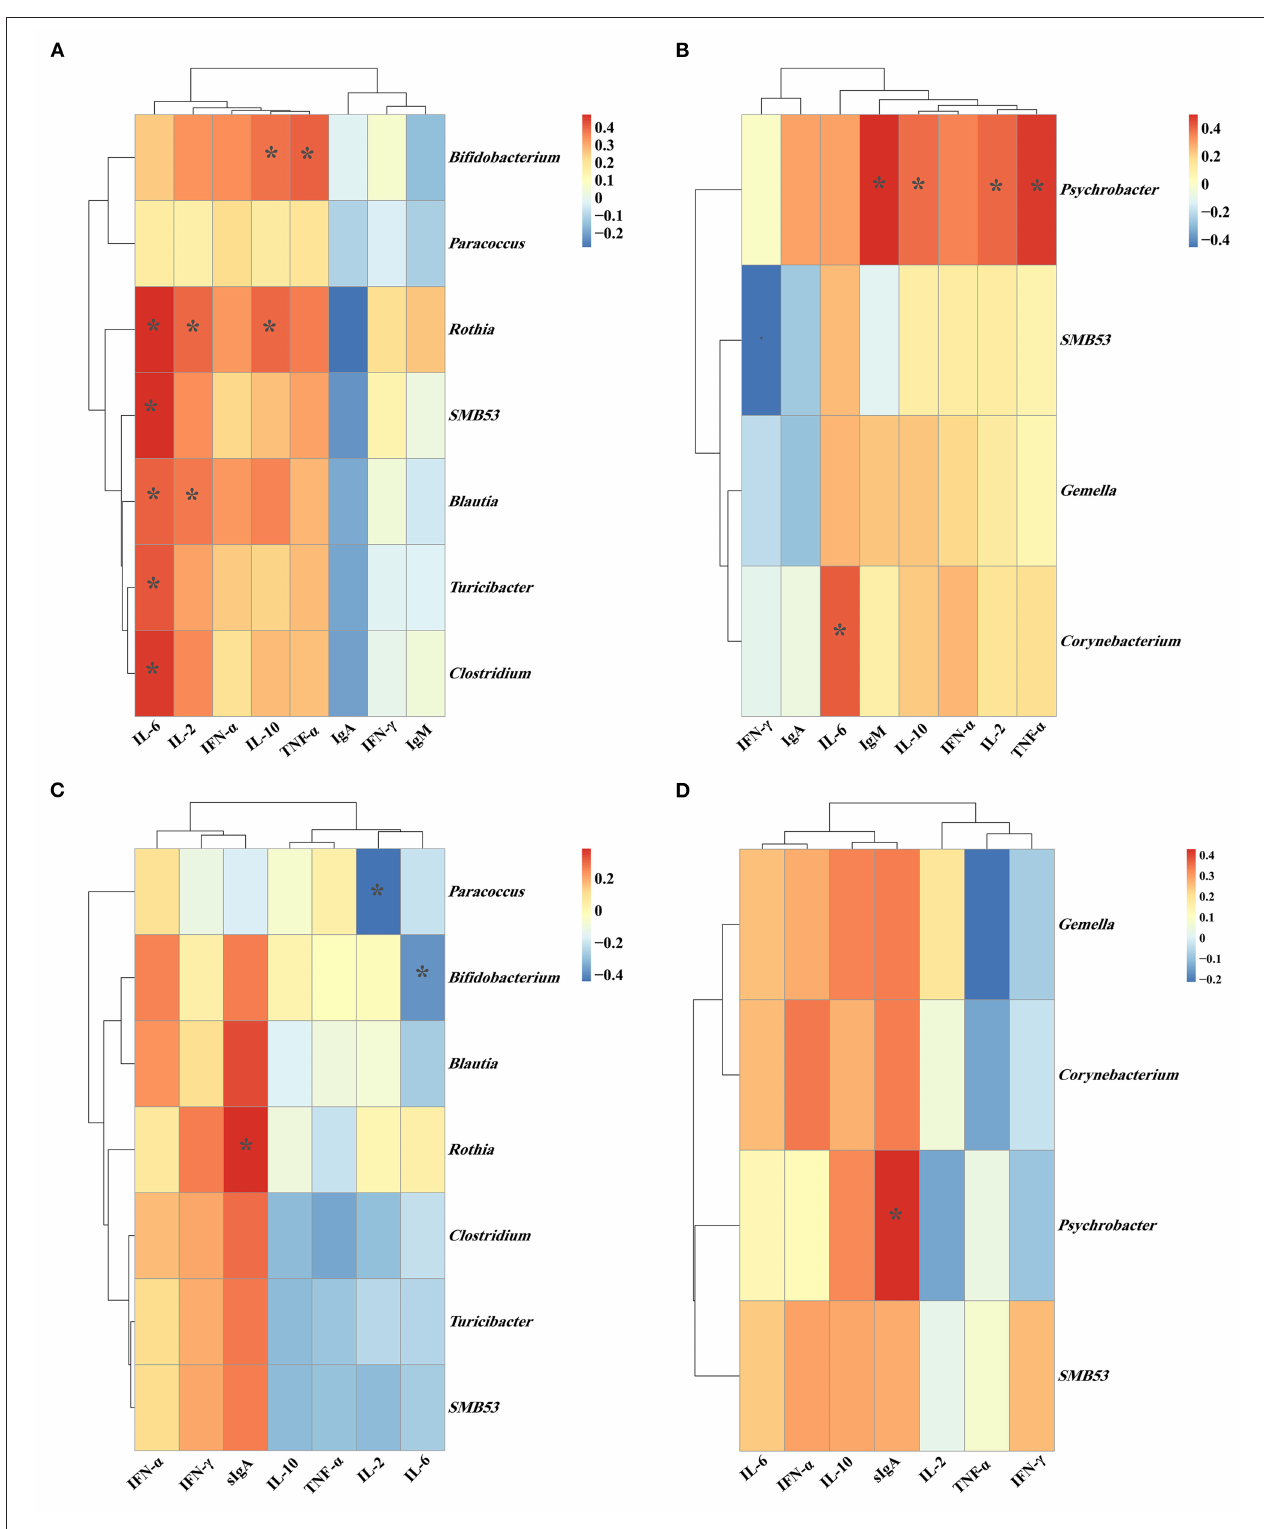
FIGURE 9 | The Spearman correlation between the (A) plasma immune-related parameters and jejunal microbiota; (B) plasma immune-related parameters and ileal microbiota; (C) jejunal immune-related parameters and jejunal microbiota; (D) ileal immune-related parameters and ileal microbiota. * P < 0.05. Cells are colored based upon the Spearman correlation coefficient between the significantly altered genera and immune-related parameters; the red and blue represents a significantly positive correlation and negative correlation, respectively.